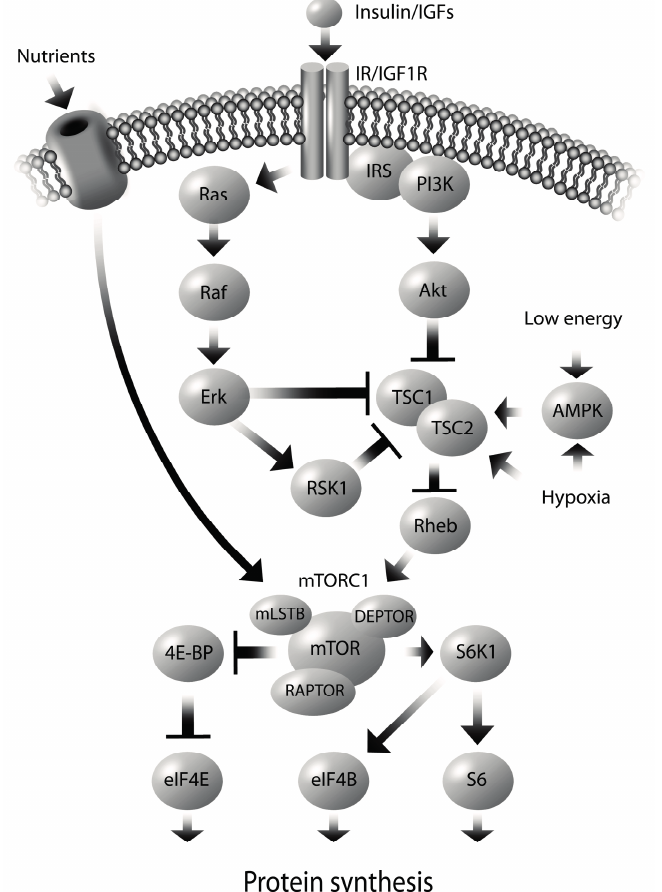
Figure 2. Regulation of the mTORC1. Various upstream kinases (Akt/PI3K, ERK1/2, RSK1) converge on TSC1/2, which regulates mTOR through Rheb.